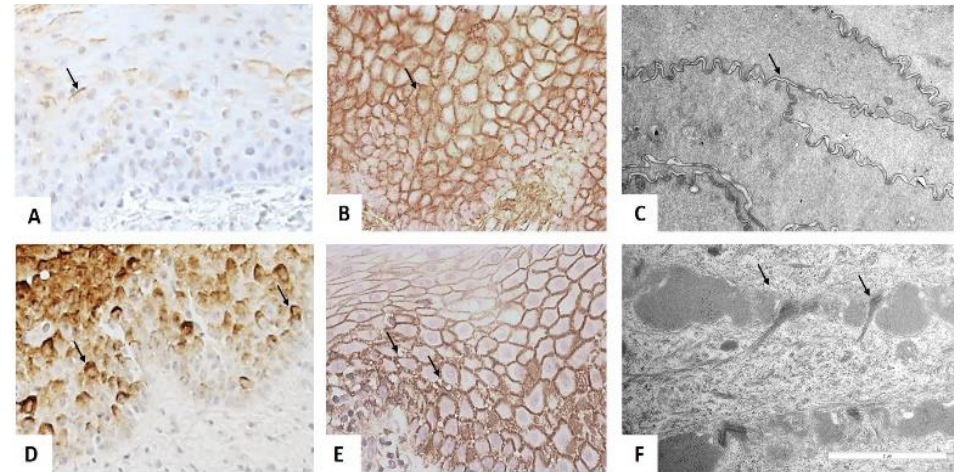
Figure 3. In controls, MUC1 expression is faint in the apical surface of basal and supra-basal cell layers (arrow) (Bar = 200 µm) ( A ). In the irradiated sample, MUC1 expressed involving all the apical, lateral, and basal surfaces of the basal and supra-basal cells (arrows) (Bar = 200 µm) ( D ). HA is expressed on the plasma membrane of control (Bar = 200 µm) ( B ). The HA staining in the irradiated epithelium at the plasma membrane is clear and shows the presence of numerous vacuoles (arrows) (Bar = 200 µm) ( E ). Transmission electron microscopic images showing cell junctions are regularly arranged in controls ( C ), whereas in irradiated, the intercellular junctions are disrupted and broken (arrows) ( F ) (Bar = 2 µm).